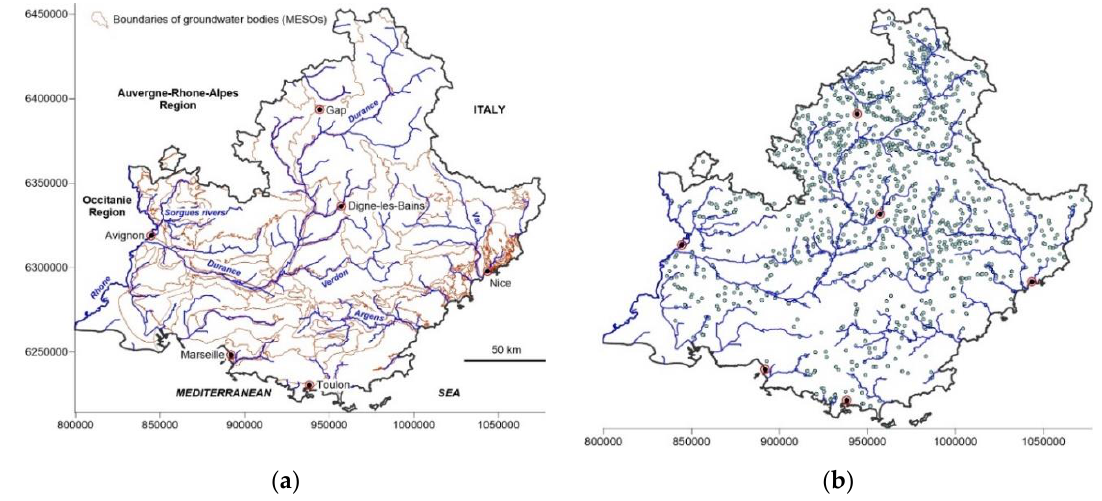
Figure 1. Provence-Alpes-Côte d’Azur region, ( a ) drainage network and groundwater Masse d’Eau Souterraines (MESO), ( b ) groundwater production wells (Coordinates are Lambert 93).